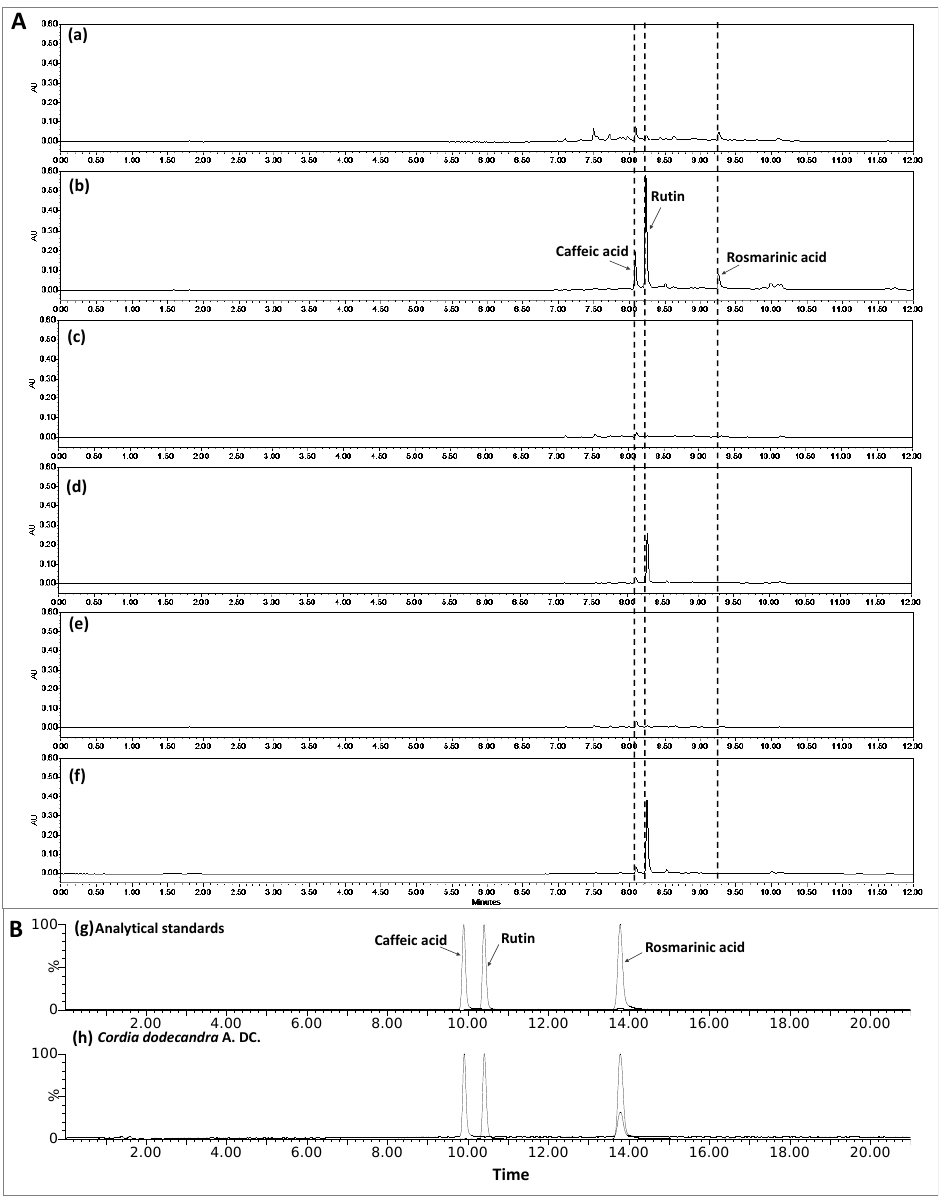
Figure 1. ( A ) Chromatograms of main phenolic compounds identified in Cordia dodecandra A. DC. fruit extracts obtained by UPLC-DAD at 350 nm: ( a ) pulp and ( b ) peel of fruit at the immature stage; ( c ) pulp and ( d ) peel of fruit at the semimature stage; and ( e ) pulp and ( f ) peel of fruit at the mature stage. ( B ) MRM analysis obtained by UPLC-DAD-ESI-MS/MS ( g ) analytical standards and ( h ) Cordia dodecandra A DC. fruit extract.